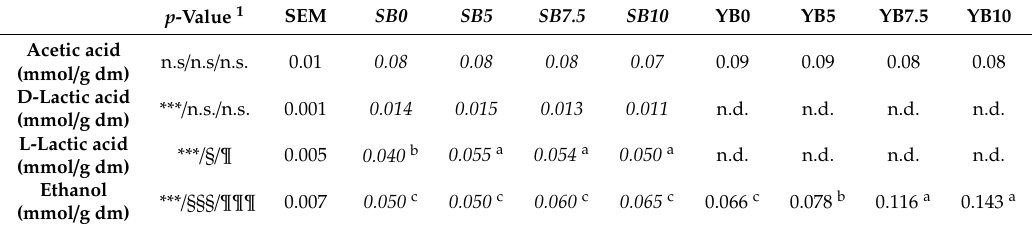
Table 4. Concentration of main fermentative metabolites in cooked bread. Data reported in italics were already published in Sanmartin et al., 2020 [39].